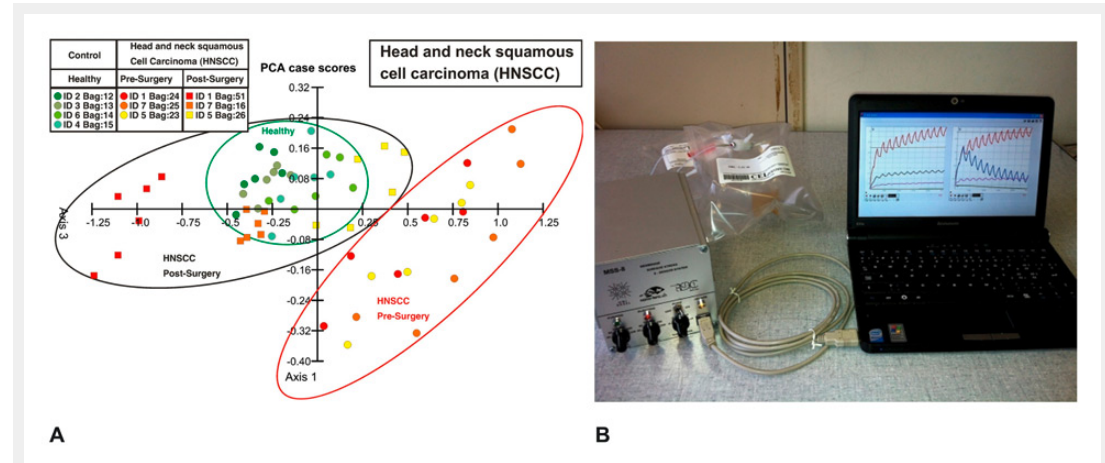
(A) Principal Component Analysis plot showing three distinct clusters (indicated with ellipses) that represent healthy control persons, head and neck squamous cell carcinoma (HNSCC) patients before surgery and HNSCC patients after surgery, i.e. after removal of the tumour by surgery. The points of the HNSCC patients after surgery are at a similar location in the PCA plot as those from the healthy persons and differ clearly from the points of the HNSCC patients before surgery, indicating that the removal of the tumour has been successful. (B) Portable USB-powered setup for mobile characterisation of patients' breath samples using polymer-coated membrane surface stress sensors. From left to right: Measurement system containing chamber with piezo membrane sensor array and pumps for aspiration of sample; breath sample bags; netbook with operating and analysis